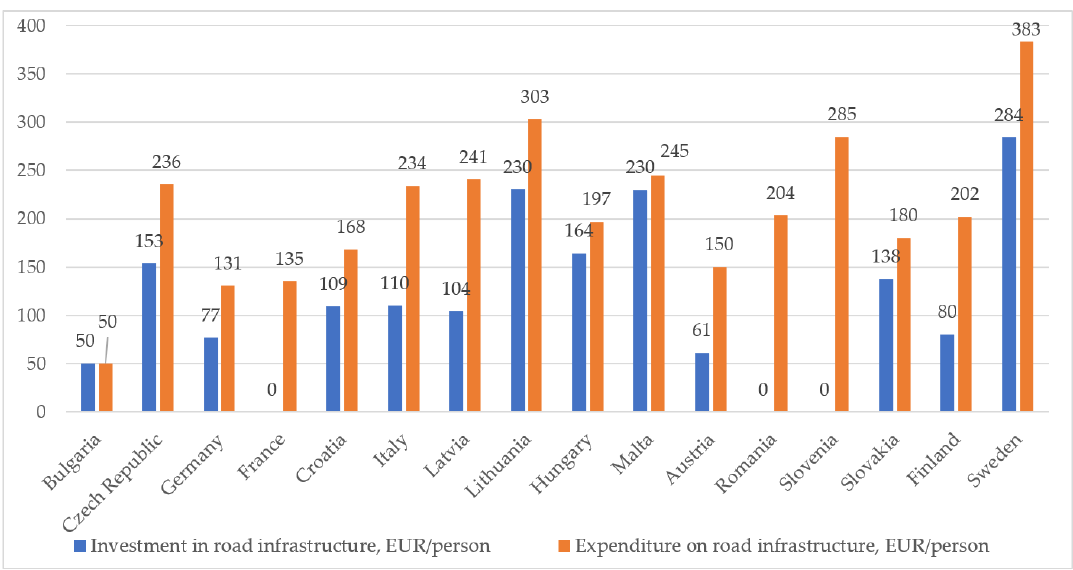
Figure 12. Investments and expenditures on road transport infrastructure in EU countries in 2020, EUR/person. Source: [74].